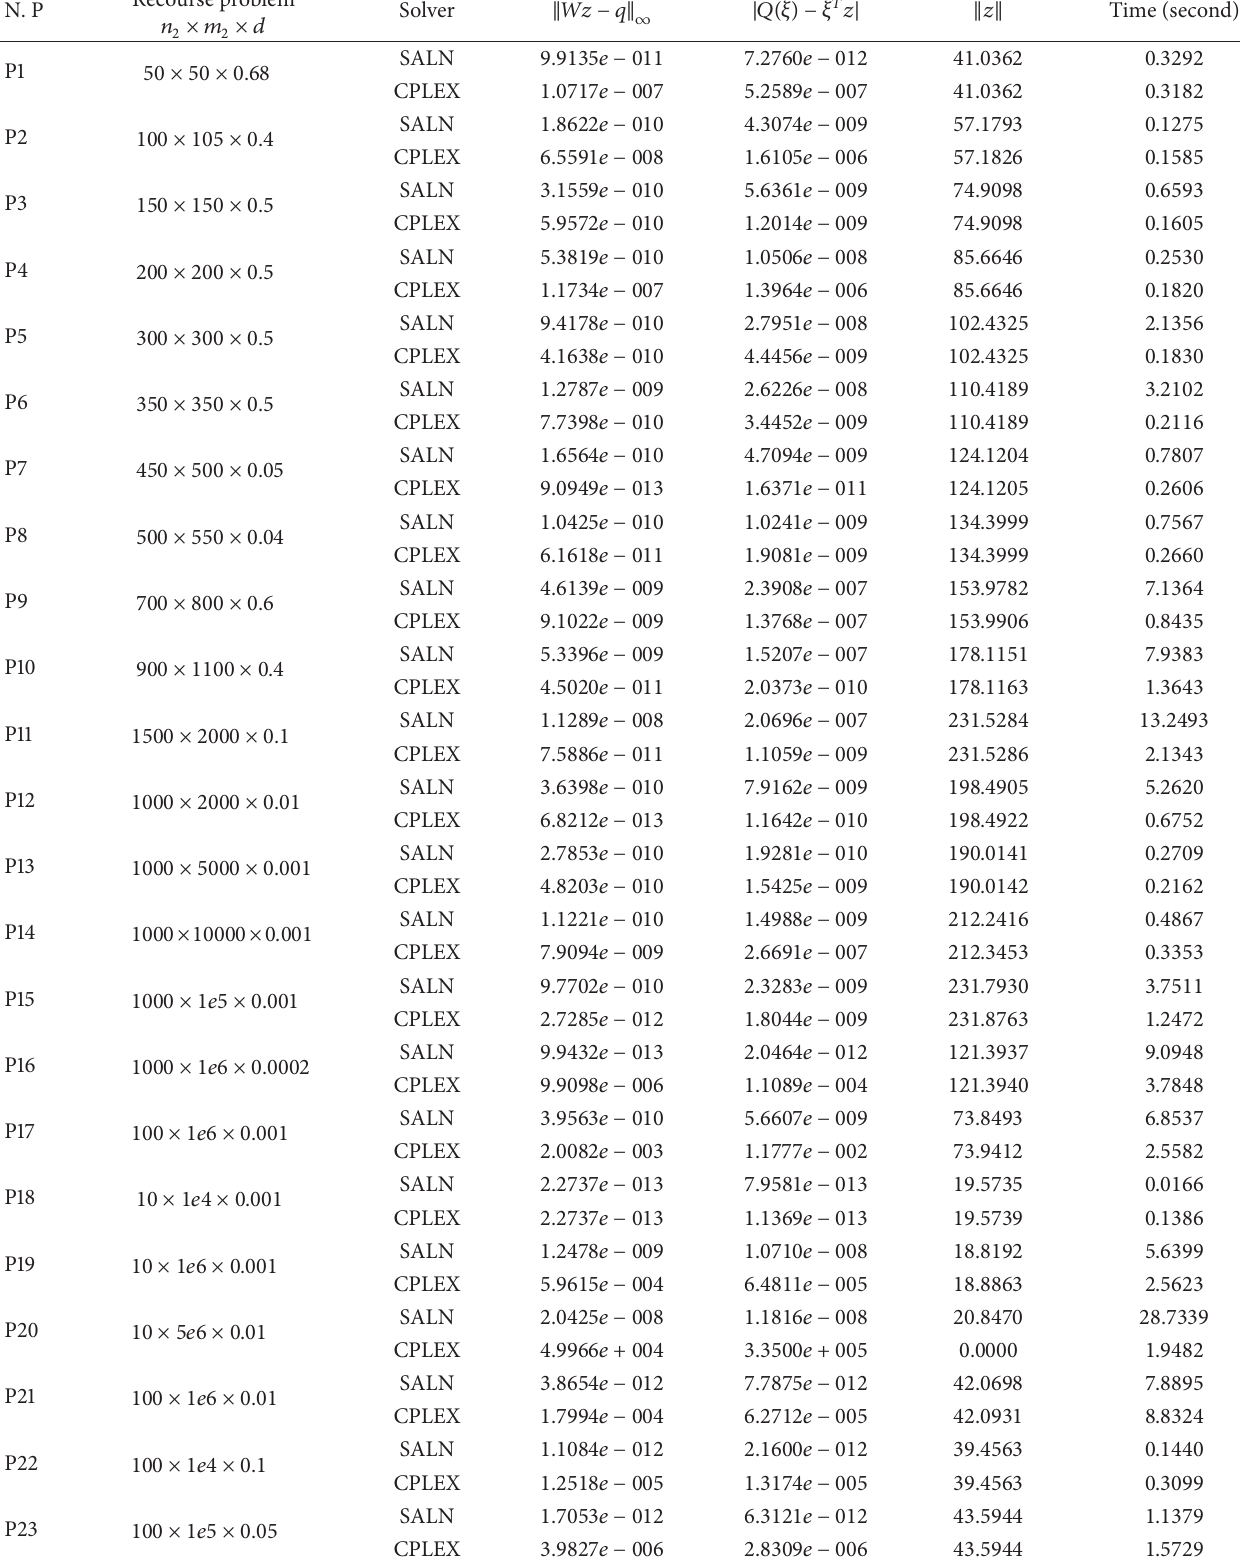
Table 1: Comparative between smooth augmented Lagrangian Newton method (SALN) and CPLEX solver. N.